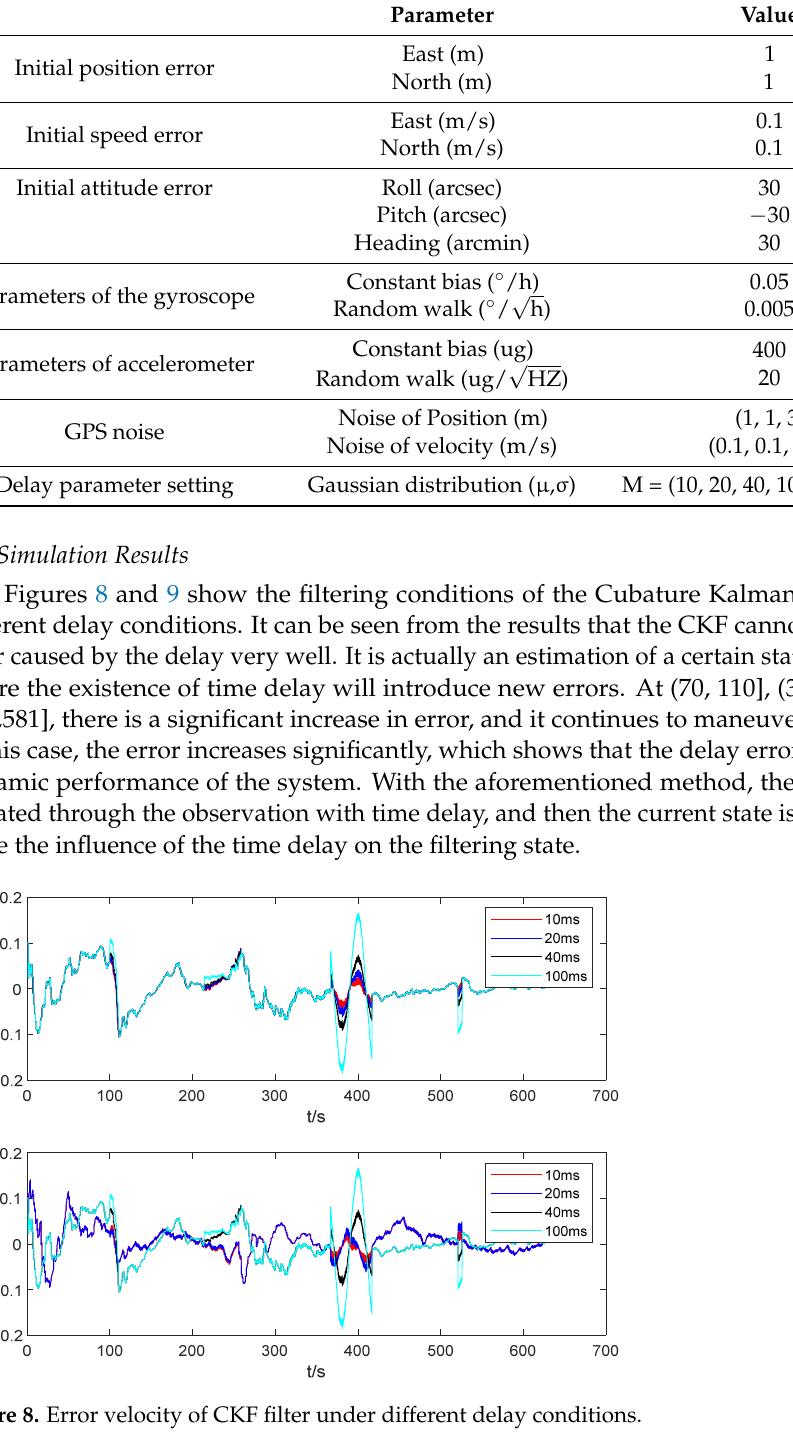
Figure 8. Error velocity of CKF filter under different delay conditions.